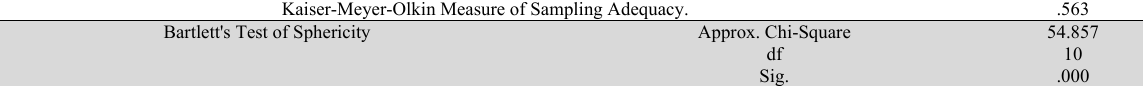
The result of KMO TEST Kaiser-Meyer-Olkin Measure of Sampling Adequacy.